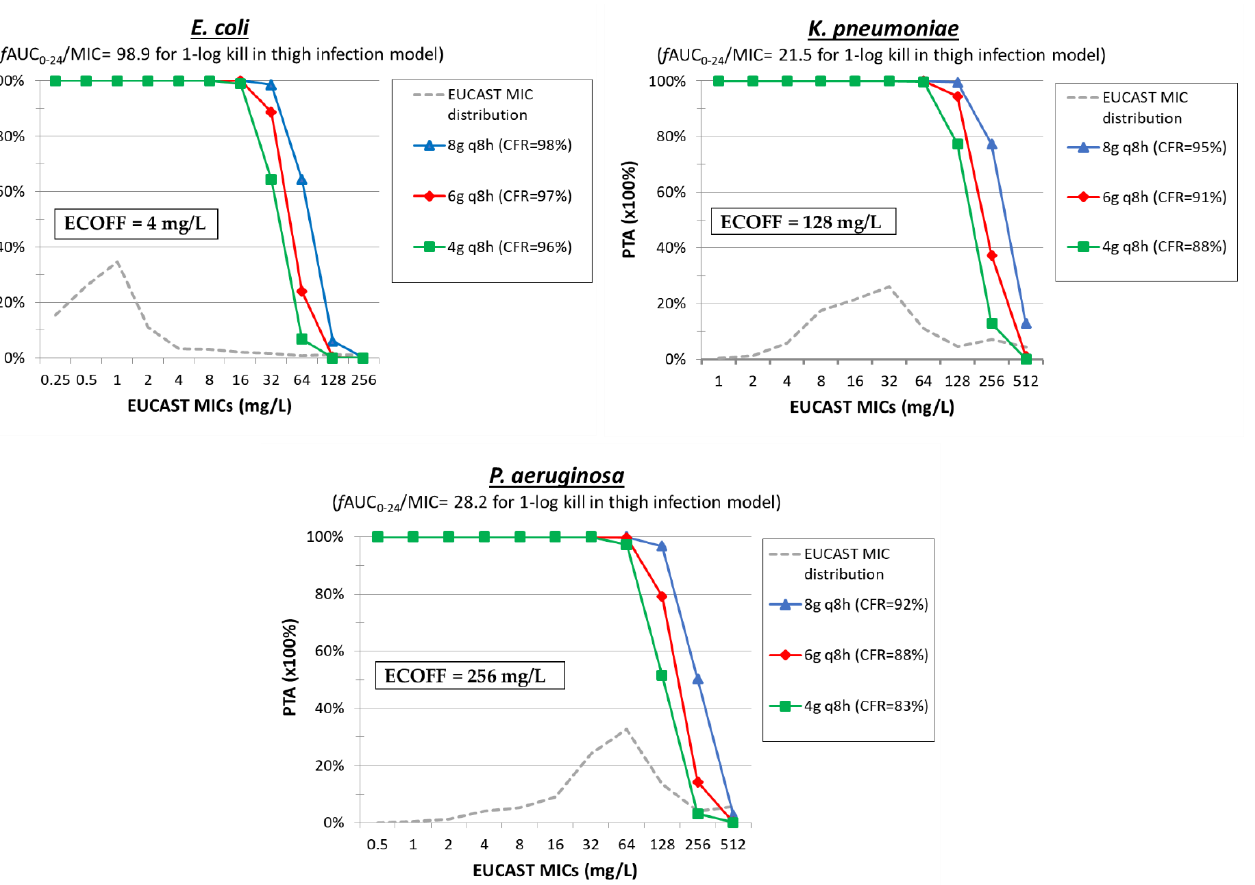
Figure 4. Probability of target attainment (PTA) of fosfomycin at different dosing regimens against isolates with increasing MIC. The cumulative fraction of response (CFR) is shown for a collection of isolates with the EUCAST MIC distribution.